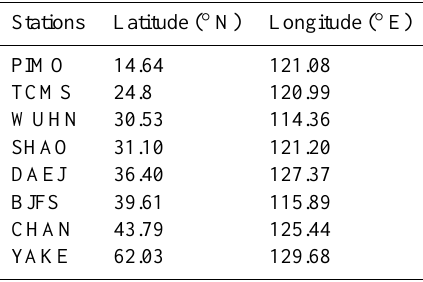
Figure 1. F107 variations during the solar minimum of 2007–2009.